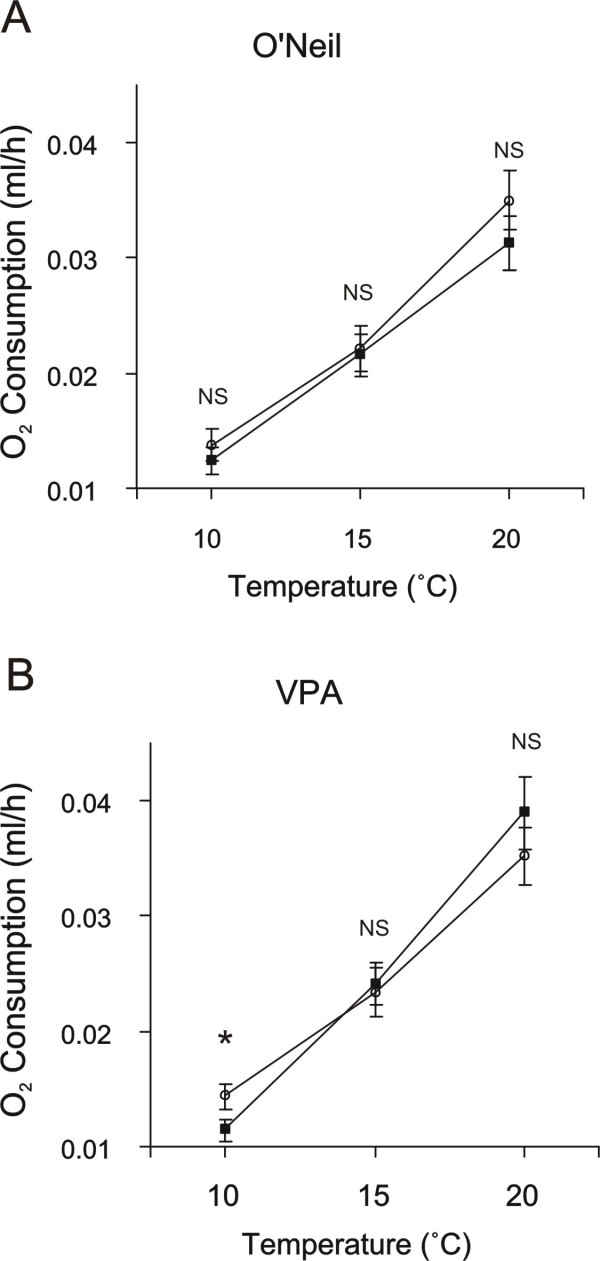
MMR Profiles by Location and Phenotype. MMR profiles depicting O2 consumption rates across temperatures for striped and black morphs for (a) O'Neil and (b) VPA. Least-Square Means (adjusted for body mass variation between groups) for whole body O2 consumption rate. Closed squares and open circles are black morphs and striped morphs respectively. Error bars represent ± 1 SE. An asterisk indicates a significant (p < 0.05) t-test, and NS indicates no significant difference between morphs